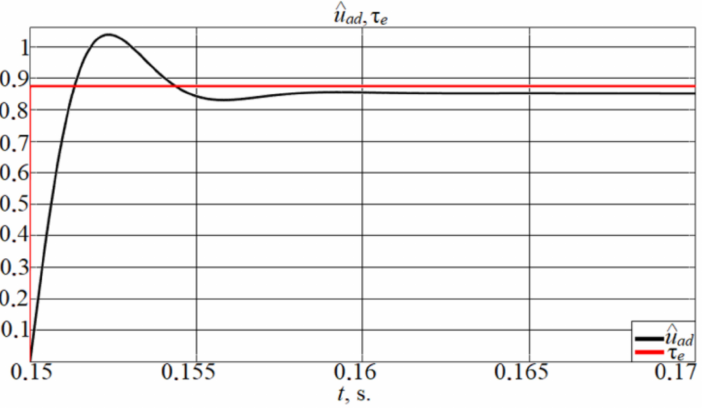
Figure 6. Comparison of ˆ u ad with τ e